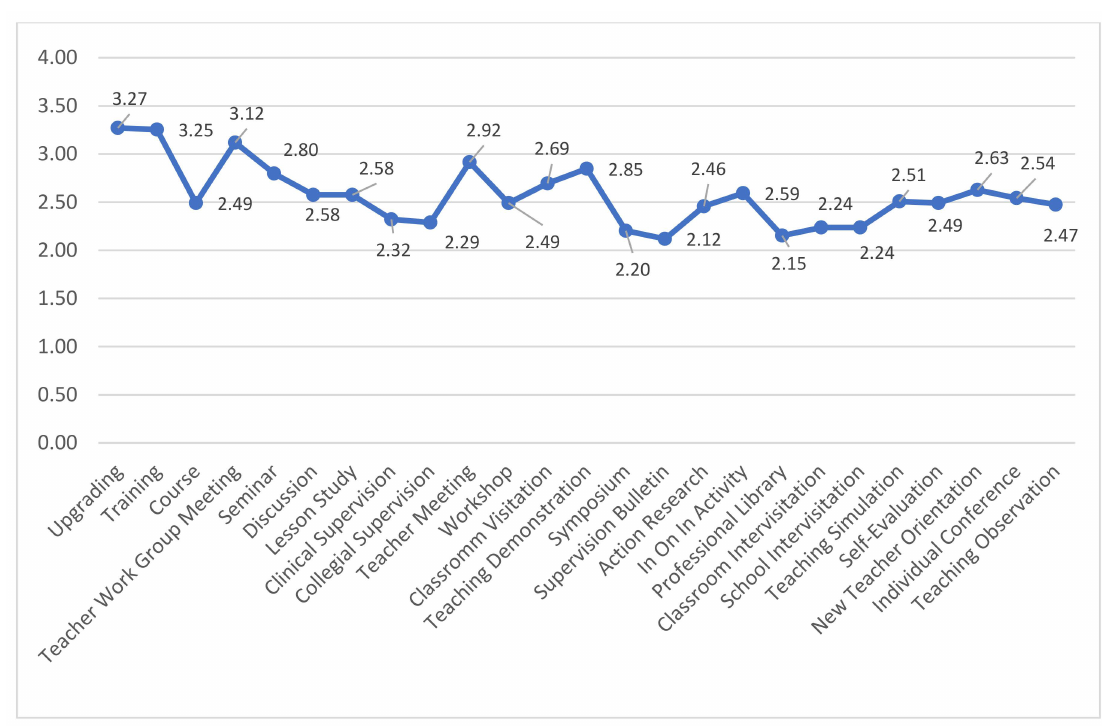
Figure 3. The effectiveness of ICT-based instructional supervision techniques.